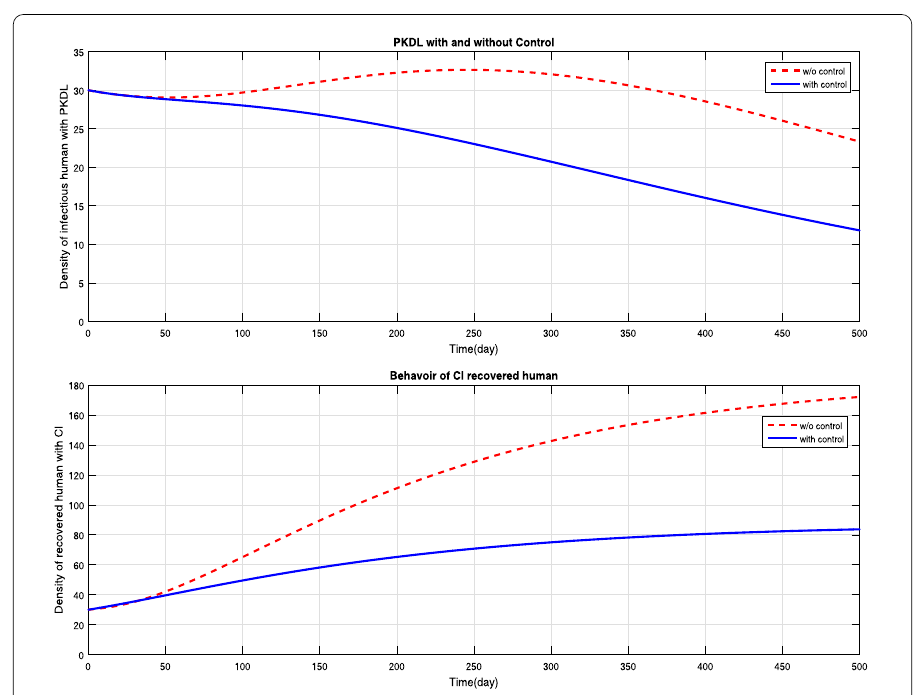
Figure 5 Comparison of behaviors with and without control in case of P 2 and R 1